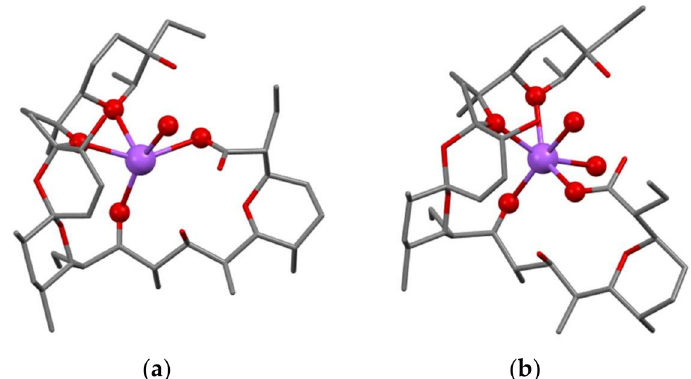
Figure 1. Crystal structure of sodium salinomycinate (SalNa) containing ( a ) one and ( b ) two water ligands [31]. Color scheme: C—grey, O—red, Na—purple (hydrogens are omitted for